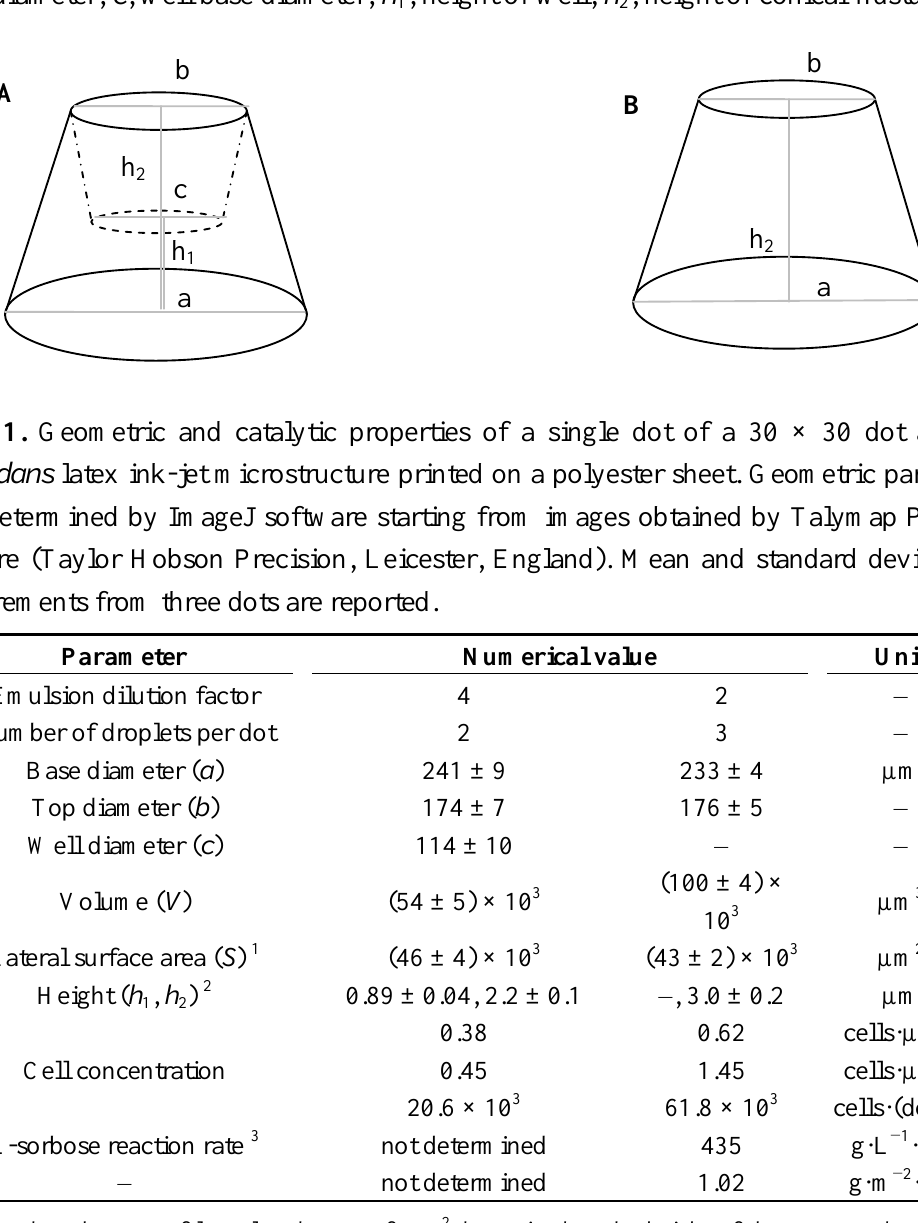
Figure 2. Schematic representation of the shape of SF091 latex dot containing G. oxydans ink-jet printed on polyester sheet: two droplets per dot, one-to-four diluted ink ( A ); three droplets per dot, one-to-two diluted ink ( B ). Geometrical parameters: a , base diameter; b , top diameter; c , well base diameter; h , height of well; h , height of conical frustum. 1 2